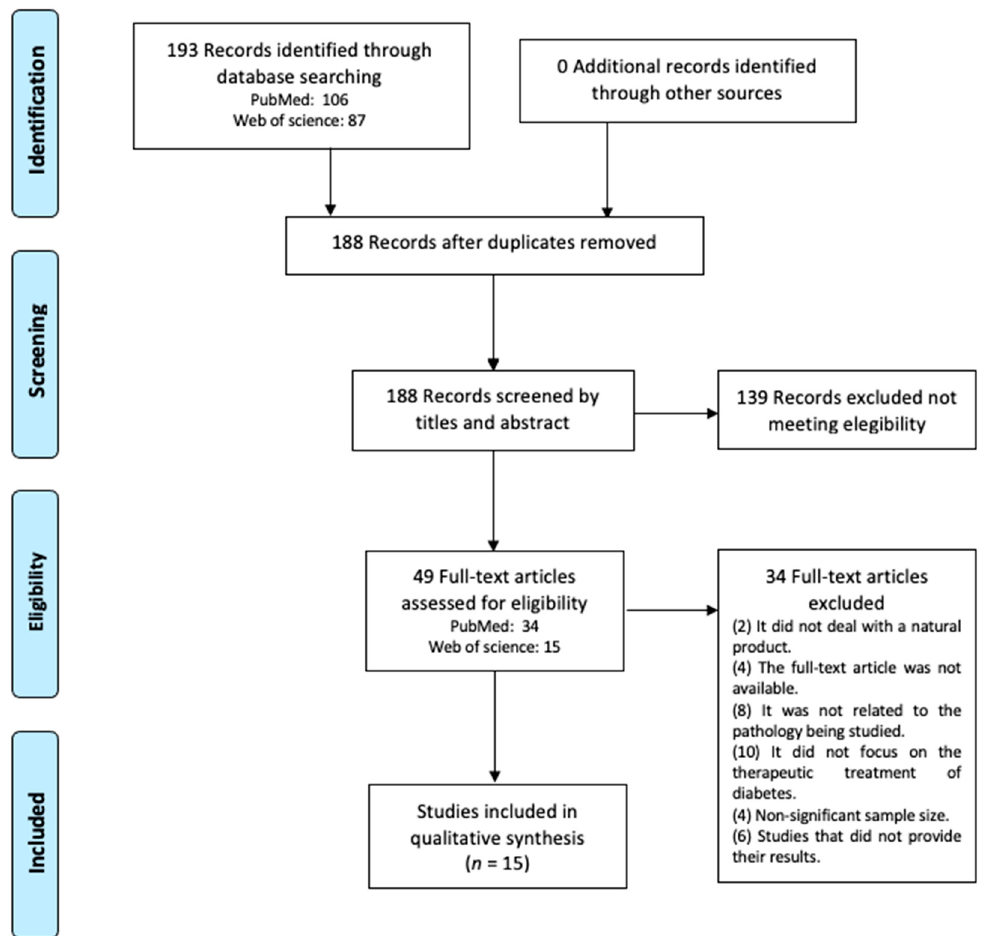
Figure 1. PRISMA flowchart of study selection process.